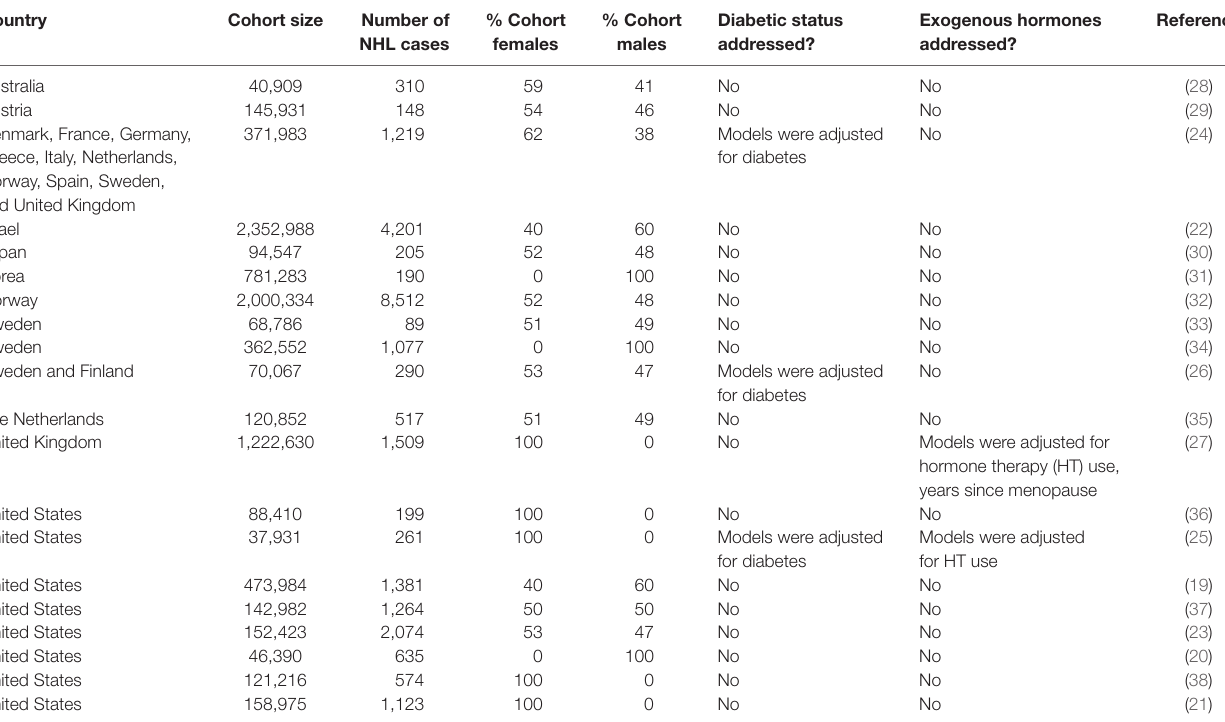
TabLe 1 | Characteristics of prospective cohort studies evaluating the risk of non-Hodgkin lymphoma (NHL) associated with obesity. Country Cohort size Number of